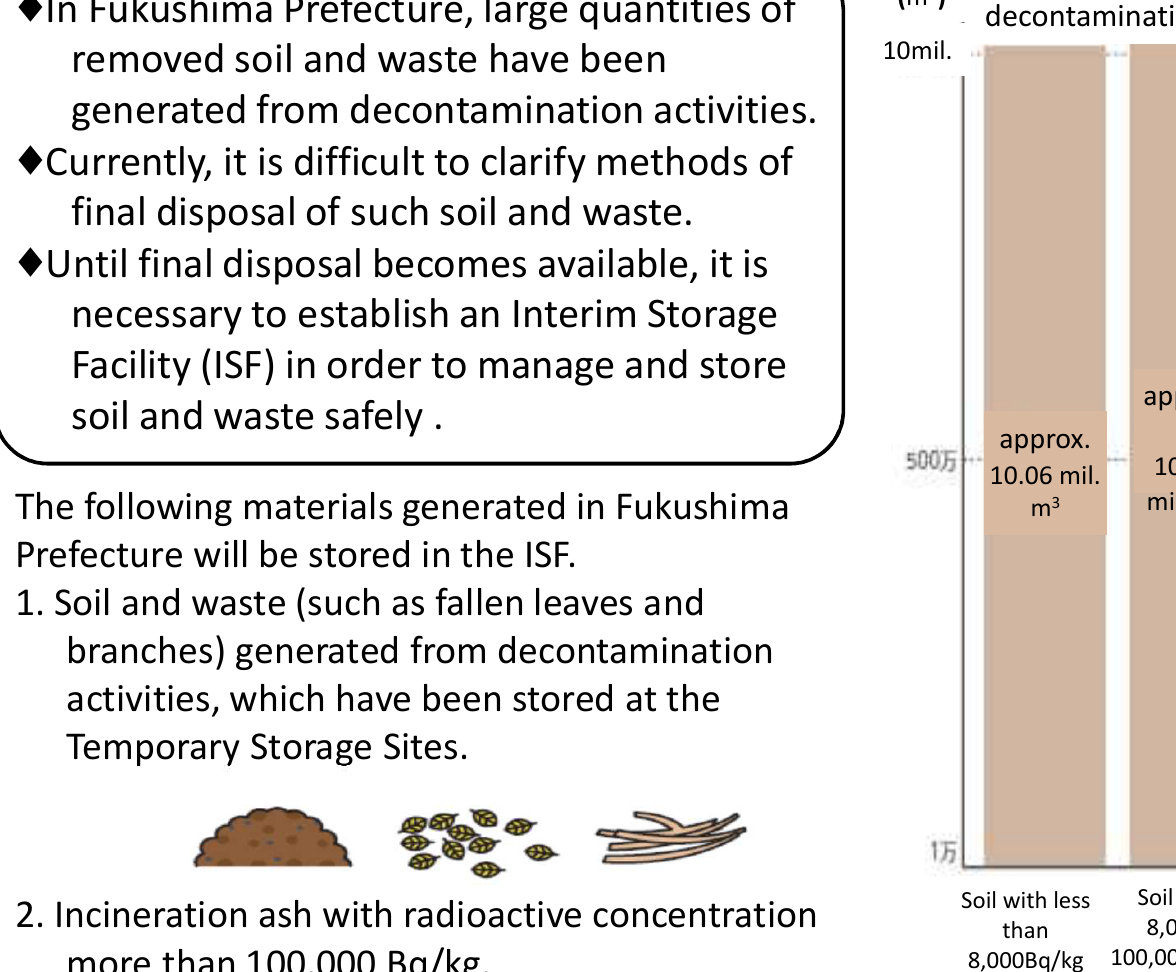
Estimated volume of generated soil, etc. from decontamination work (in case of 22 million ㎥